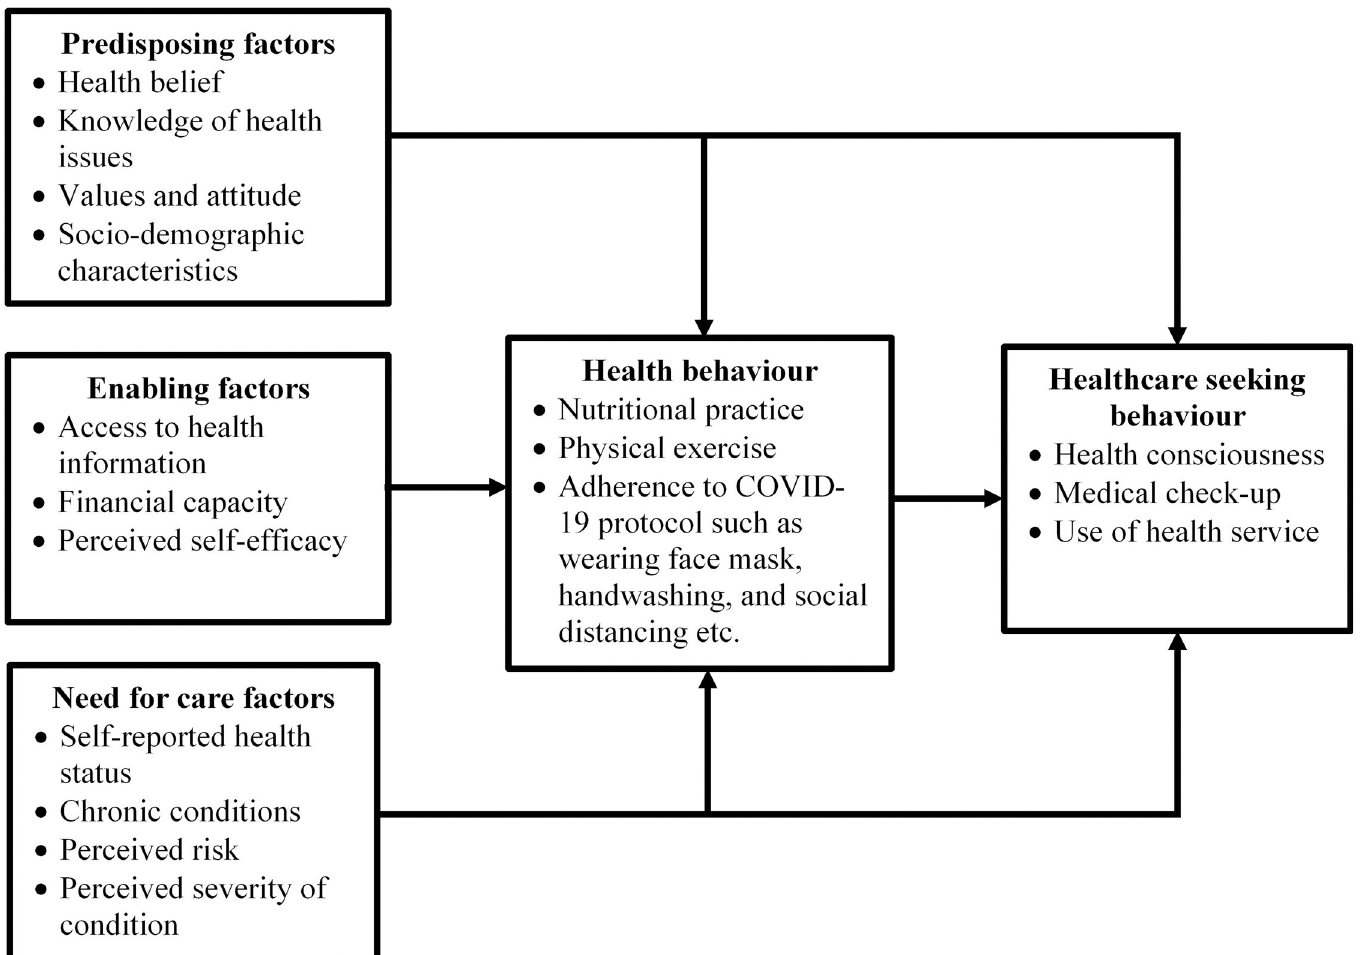
Fig 1. Health service utilization model. Source: Adapted from Andersen and Davidson [21].